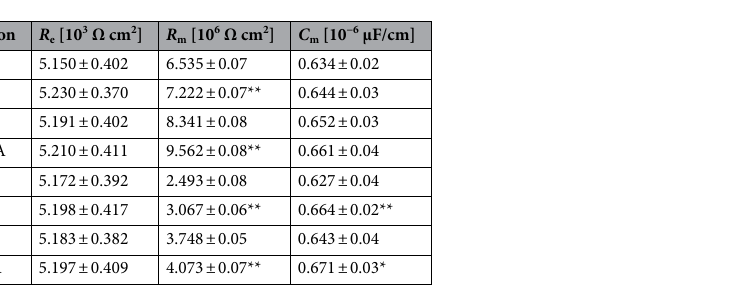
Table 3. The fitting parameters of the equivalent circuit for the impedance plots. Statistical difference in comparison to pure BLMs * p < 0.05, ** p <